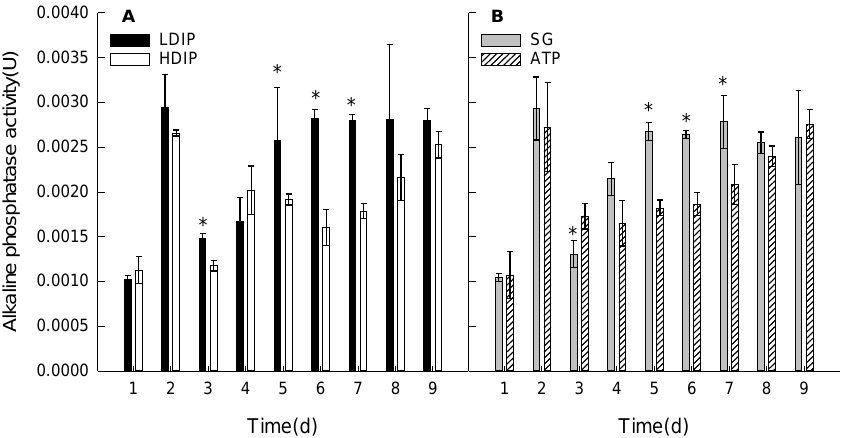
Figure 4. Changes in the alkaline phosphatase activity of C. roscoffensis in the groups of inorganic ( A ) and organic ( B ) initial phosphorus resources. (LDIP): low concentration of inorganic phosphorus; (HDIP): high concentration of inorganic phosphorus; (SG): Na 2 -glycerophosphate; (ATP): adenosine triphosphate. * statistical significance, p < 0.05.